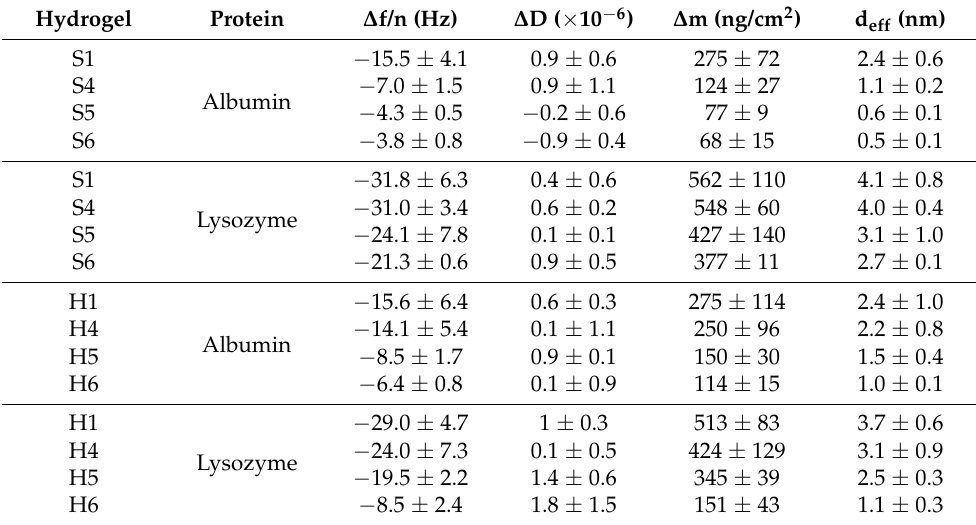
Table 3. Frequency ( ∆ f/n) and dissipation ( ∆ D) variations for the 3rd harmonic for albumin and lysozyme adsorption onto silicone and HEMA hydrogels, obtained by QCM-D. Estimated values for mass variation ( ∆ m) and layer thickness (d eff ) are also presented (average ± standard deviation, n = 4). Hydrogel Protein ∆ f/n